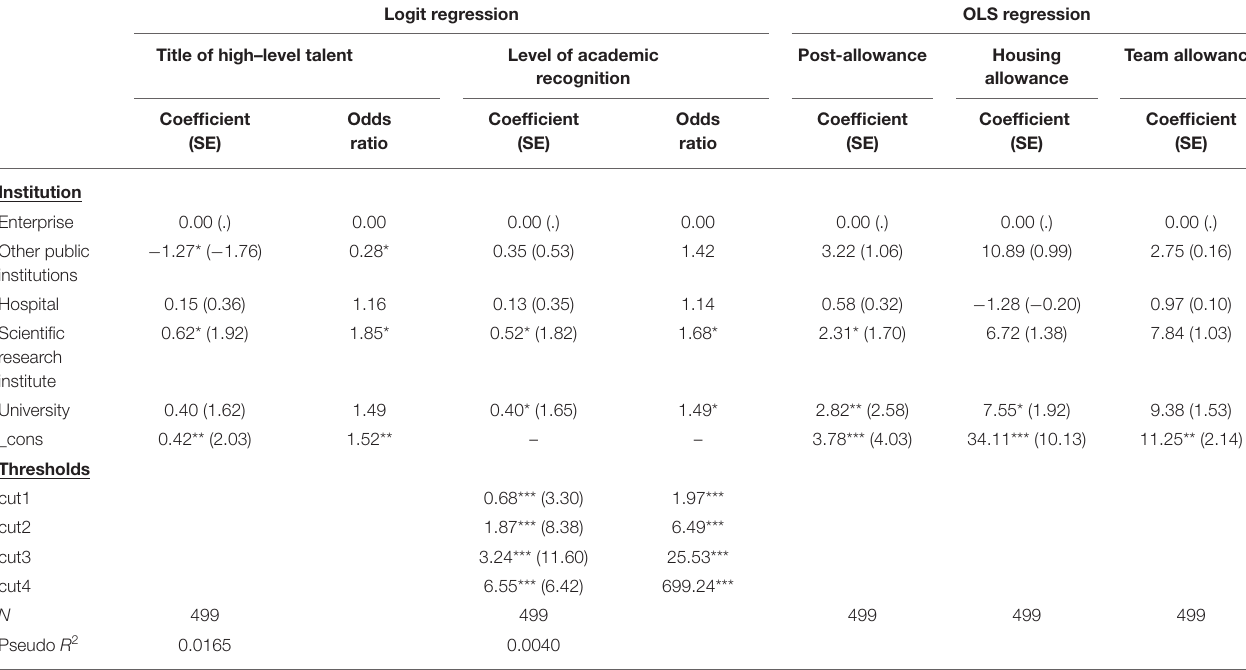
TABLE 5 | The impact of different institutions on talent selection and funding. Logit regression OLS regression